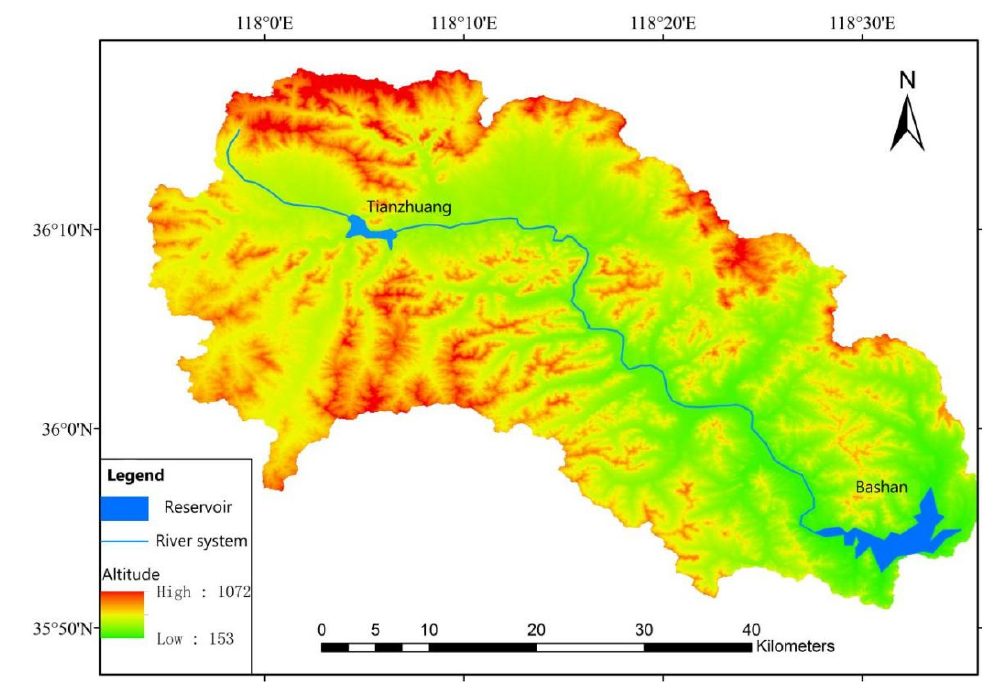
Figure 2. Watershed map of Tianzhuang–Bashan cascade reservoir system. Table 2. Basic parameters of the two reservoirs.